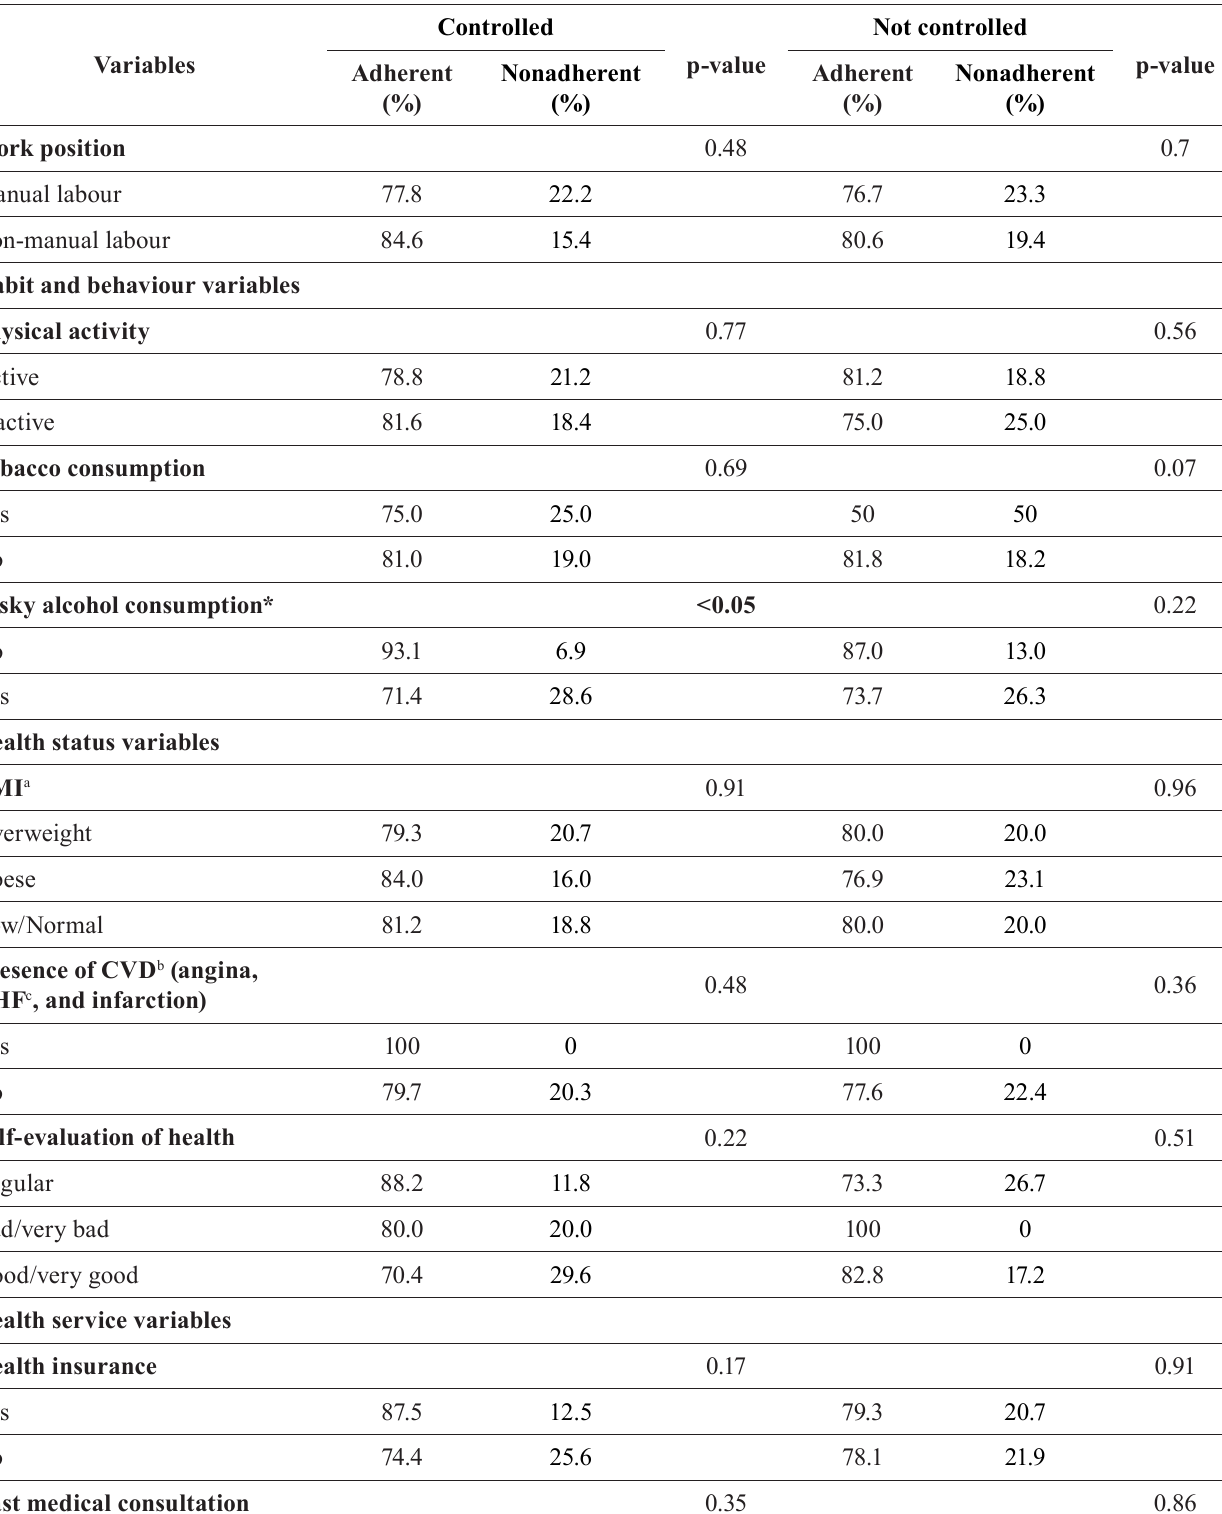
Controlled Not controlled p-value p-value Adherent Nonadherent Adherent Nonadherent (%) (%) (%) (%) 77.8